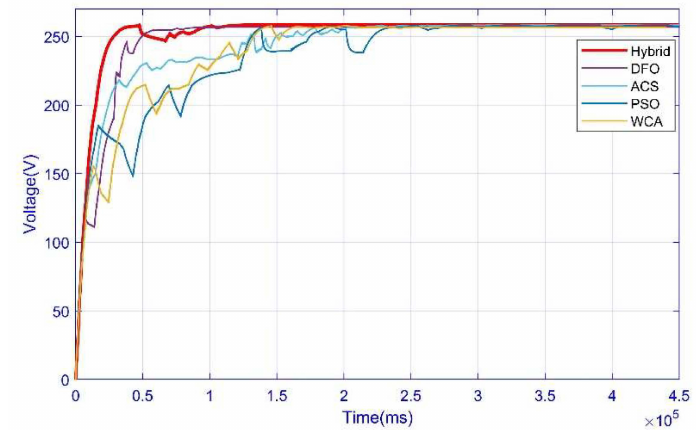
Figure 5. Case 1: Duty cycle comparison of hybrid with other techniques.